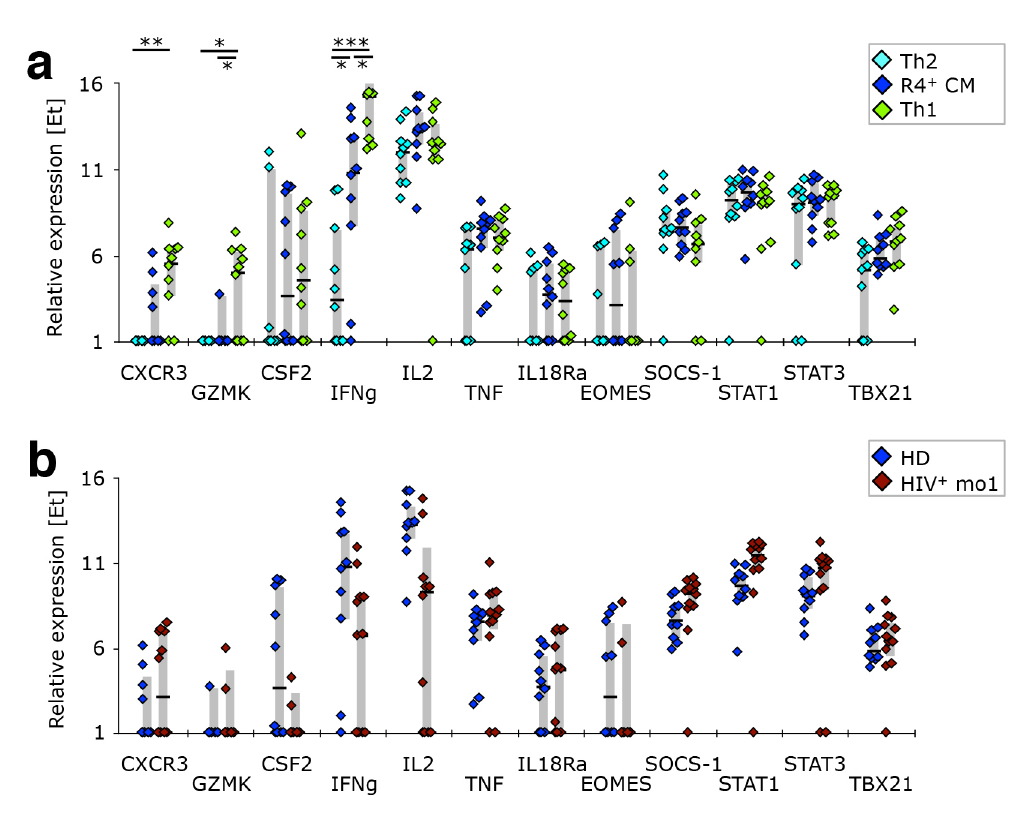
Supplementary Figure 5. CCR4 + T resemble Th -like cells in respect to their expression of Th CM 2 1 associated genes. PBMC from healthy donors, as well as cells isolated before or after 1 or 12 months of ART from HIV-1-infected adults were stained with the “sorting” panel (Supplementary Table 1). Subsets of CD4 + T cells were sorted as indicated in Supplementary Figure 4 and their gene expression profiles determined by multi-parametric quantitative RT-PCR. (A) Th -associated genes were compared in Th - 1 2 like, CCR4 + T , and Th -like cells isolated from healthy donors. (B) CCR4 + T from HIV-1 + patients CM 1 CM after 1 month of ART were compared to their counterparts from healthy donors in respect to expression of Th -associated genes. Bar graphs show interquartile ranges, median bars, as well as individual data points. 1 Statistically significant differences are indicated: * P < 0.01, ** P < 0.001, *** P <